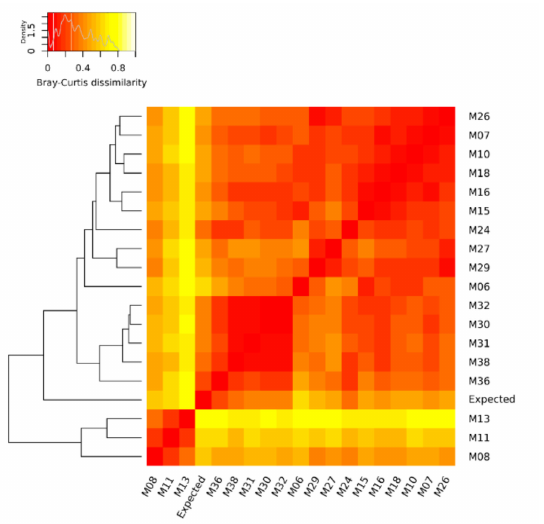
Figure 2. Heat map of Bray–Curtis dissimilarity and average linkage clustering dendrogram showing the similarity between the benchmark (expected) and the DNA metagenomic datasets obtained from spiked salmon, considering the microorganisms of the mock community. In the heat map, when a cell is colored in red, it indicates that the two associated samples (in the corresponding row and column) have an identical composition, while a white cell refers to two samples with the most di ff erent